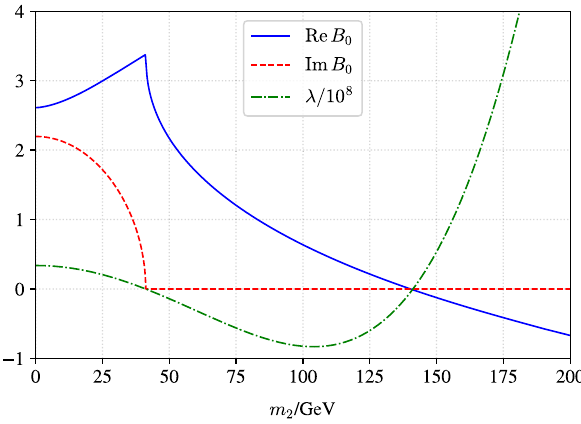
, m 2 ) for masses m = 1 1 2